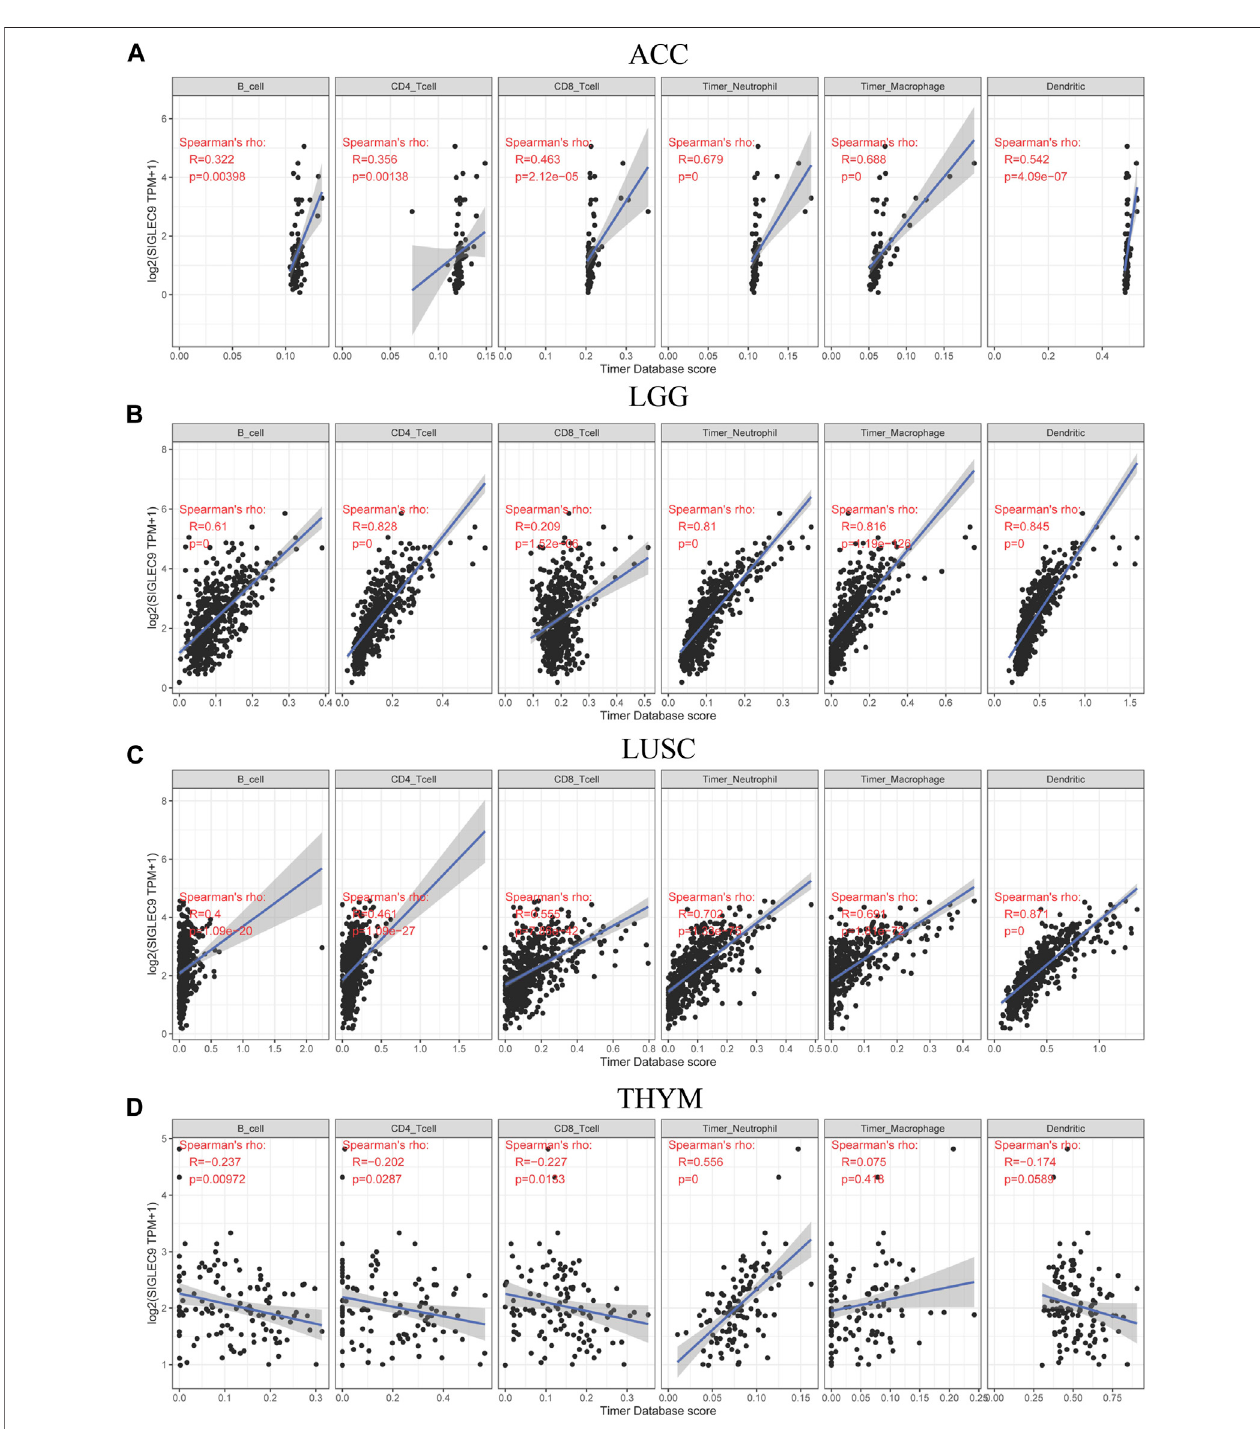
FIGURE5| CorrelationbetweenSiglec-9mRNAexpressionandimmunecellin fi ltration(Bcell,CD4 + Tcell,CD8 + Tcell,neutrophil,macrophage,anddendriticcell) in ACC (A) , LGG (B) , LUSC (C) , and THYM (D) according to TIMER. (Spearman correlation, p < 0.05 was considered signi fi cant. The larger the R -value, the greater the correlation.)